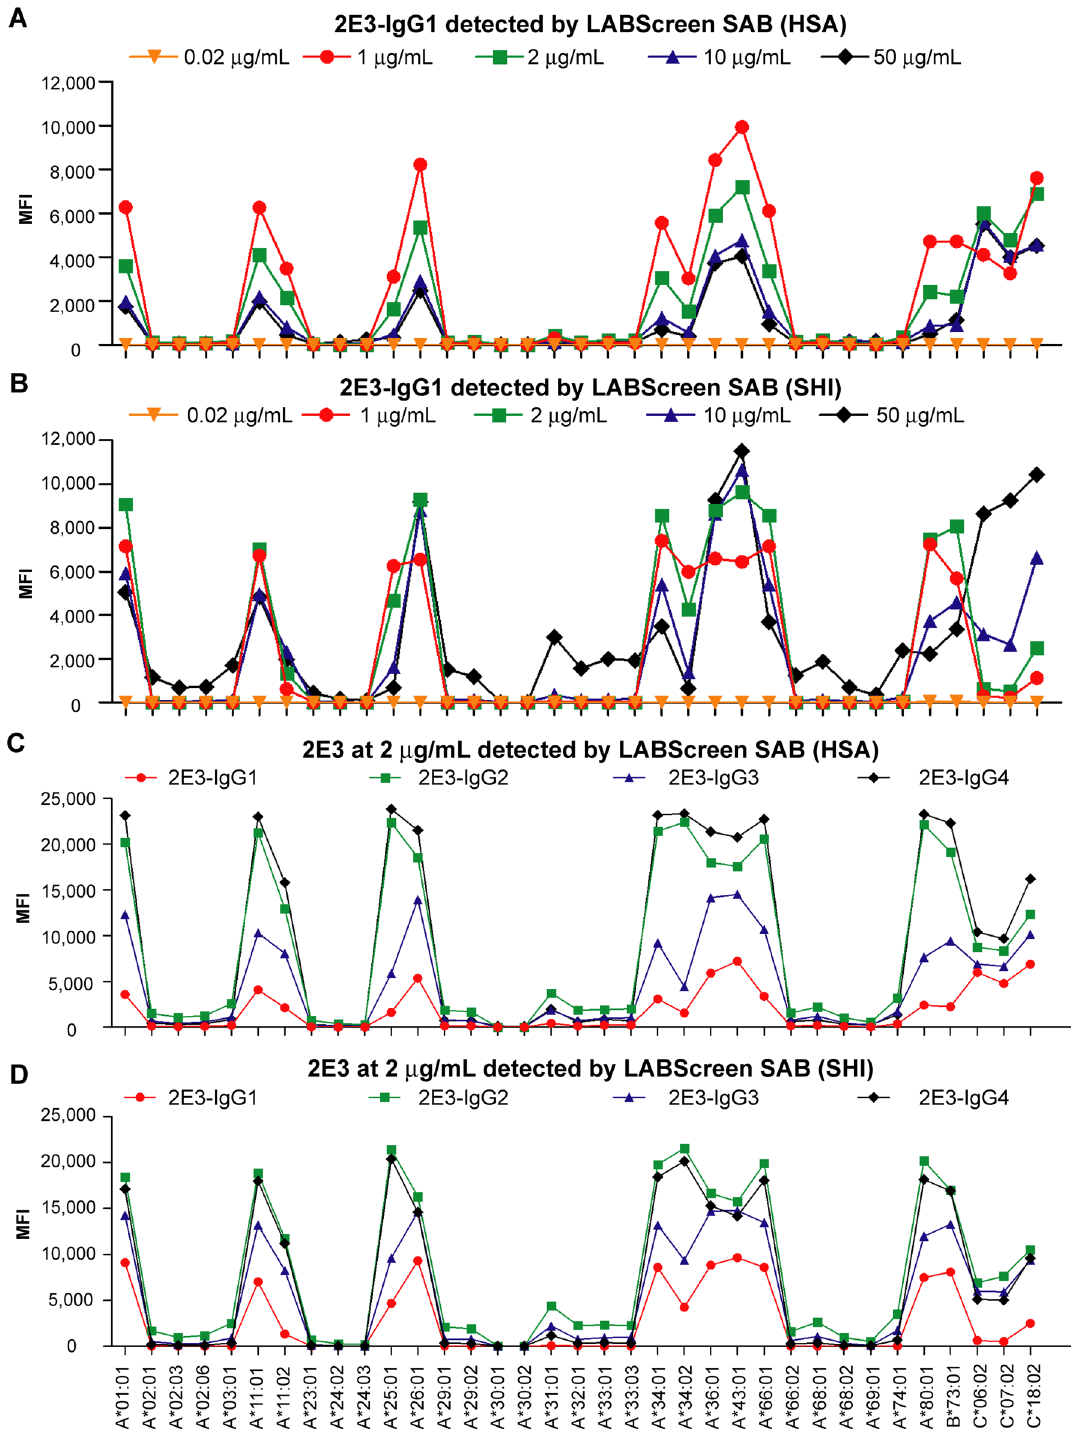
Figure 1. Antibody 2E3 detected by the SAB assay. 2E3-IgG1 was diluted in negative control serum to achieve final concentrations of 0.02 μg/mL, 1 μg/mL, 2 μg/mL, 10 μg/mL and 50 μg/mL, and tested by accredited laboratories ( A ) HSA and ( B ) SHI. All HLA-A alleles, 2E3-reactive HLA-B and HLA-C alleles are shown in the figure. Four human IgG subclasses of 2E3 were tested at 2 μg/mL by ( C ) HSA and ( D ) SHI. SAB single antigen beads; MFI mean fluorescence intensity; HSA Heath Sciences Authority, Singapore; SHI Shared Health Inc., Canada; HLA human leukocyte